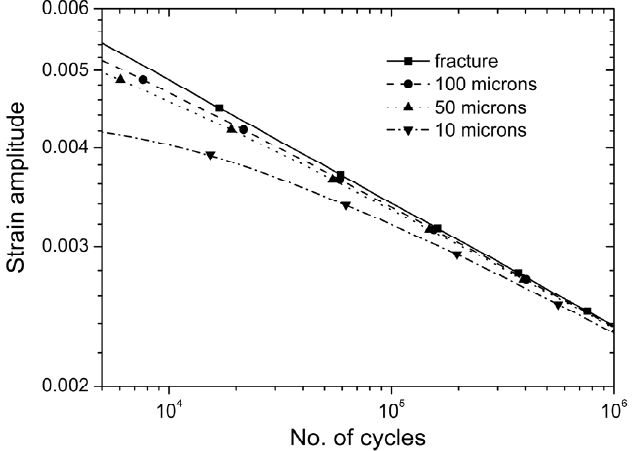
Figure 6: Initiation crack curves for Al 7075-T651